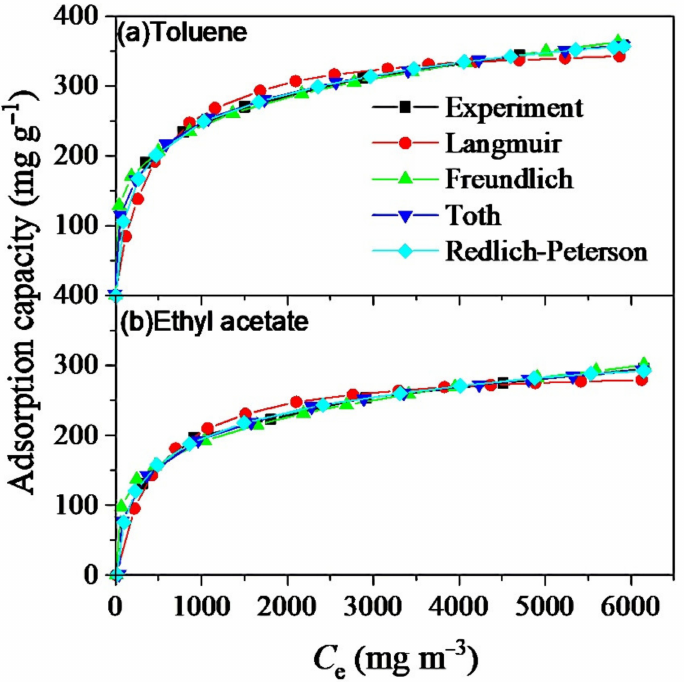
Figure 5. Adsorption isotherms of toluene ( a ) and ethyl acetate ( b ) on